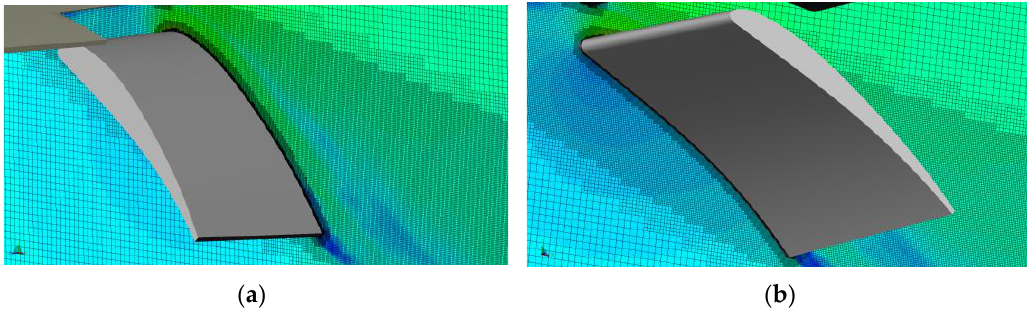
Figure 4. Computational mesh around the flap side-edge. ( a ) Side view; ( b ) bottom view.